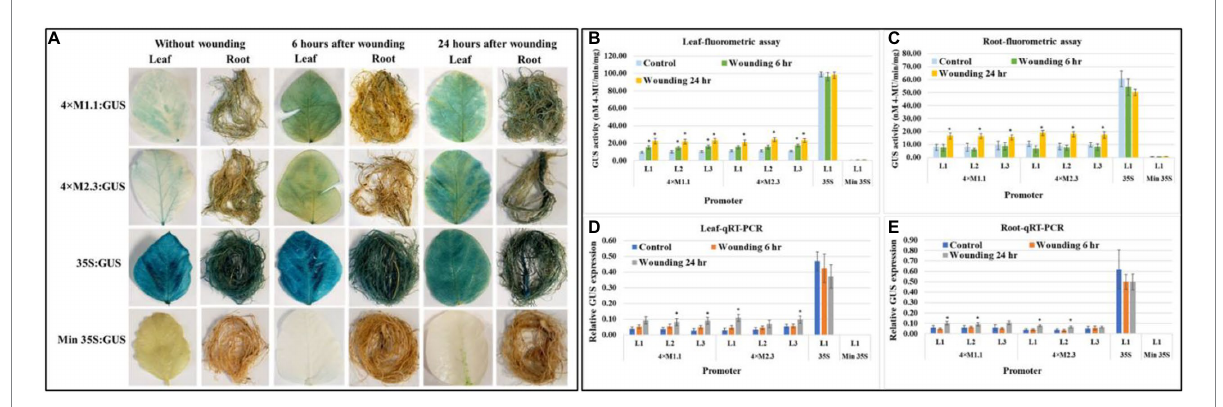
FIGURE 7 GUS activity in leaves and roots of 3-week-old T 3 transgenic soybean containing the individual promoter-GUS construct subjected to the absence (untreated control) and presence (treated) of wounding at two time points of 6 and 24 h after treatment. (A) Histochemical staining for GUS activity in transgenic soybean plants. (B,C) Fluorometric assay for GUS activity in leaf (B) and root (C) . (D,E) Quantitative real-time RT-PCR (qRT-PCR) analysis for GUS expression in leaf (D) and root (E) . The relative levels of transcripts in qRT-PCR were normalized to soybean ubiquitin gene ( GmUBI 3). Three independent transgenic lines (L1, L2, and L3) were used for 4 × M1.1 and 4 × M2.3 promoter-GUS constructs. One transgenic line (L1) was used for 35S and minimal (Min) 35S promoter-GUS constructs. Bars represent mean values of six biological replicates ± standard error. Statistical significance ( p < 0.05) was determined by two-sample paired t -test. Bars with asterisk (*) indicate significant difference compared to untreated control